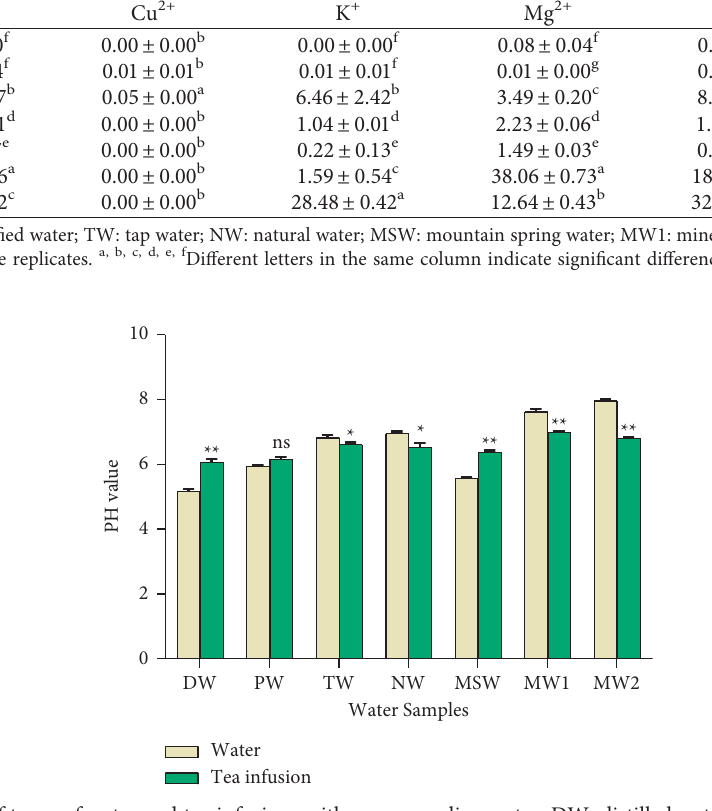
Figure 1: The pH values of types of water and tea infusions with corresponding water. DW: distilled water; PW: purified water; TW: tap the significance of differences between water and tea infusion, ns indicates p > 0 . 05, ∗ indicates p < 0 . 05, and ∗∗ indicates p < 0 . 01.